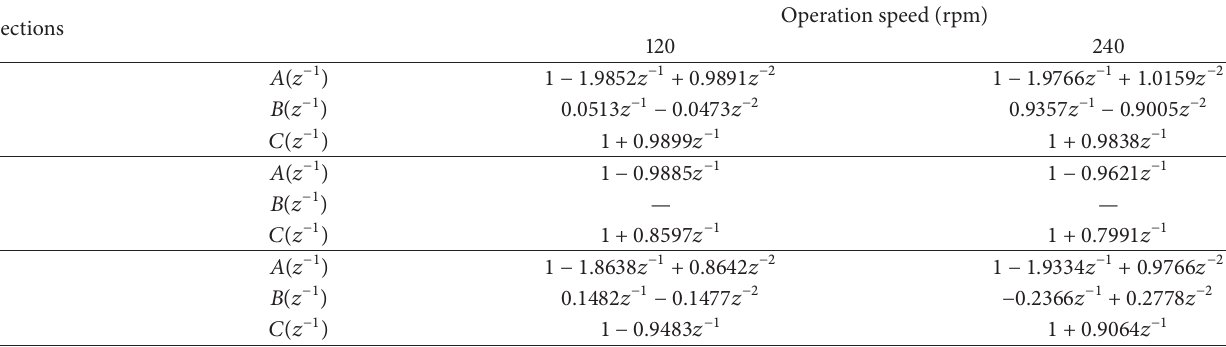
Table 1: Results of system identification for the subsystem